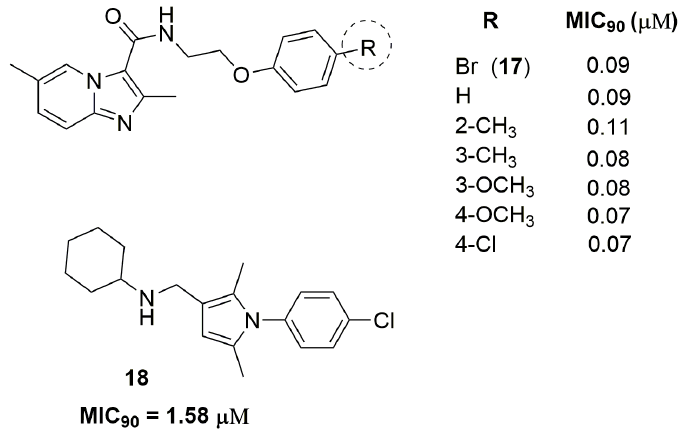
Figure 6. Compounds with antitubercular activity against MDR-TB.